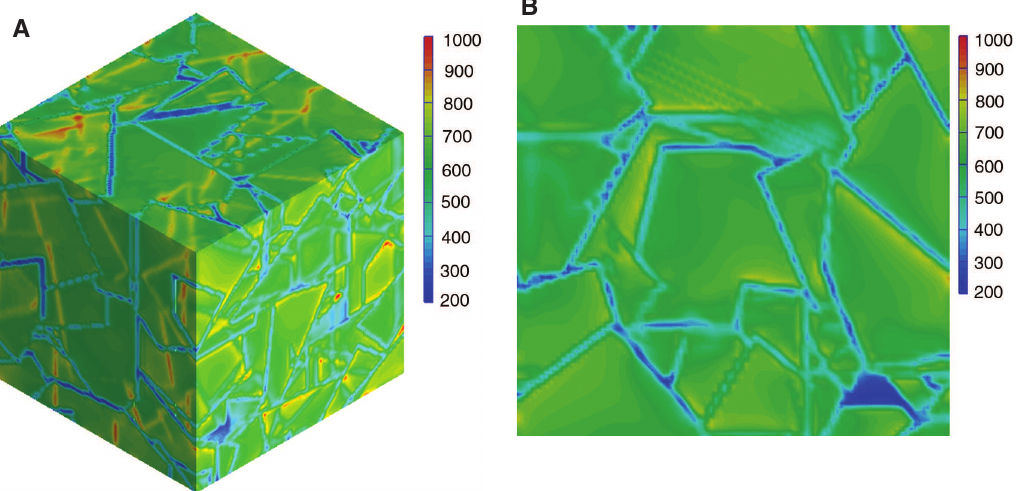
Figure 20: Stress field obtained on the basis of 3D microgeometry containing continuous boundaries between the tungsten carbide particles: (A) isometric view on the RVE and (B) exemplary section view